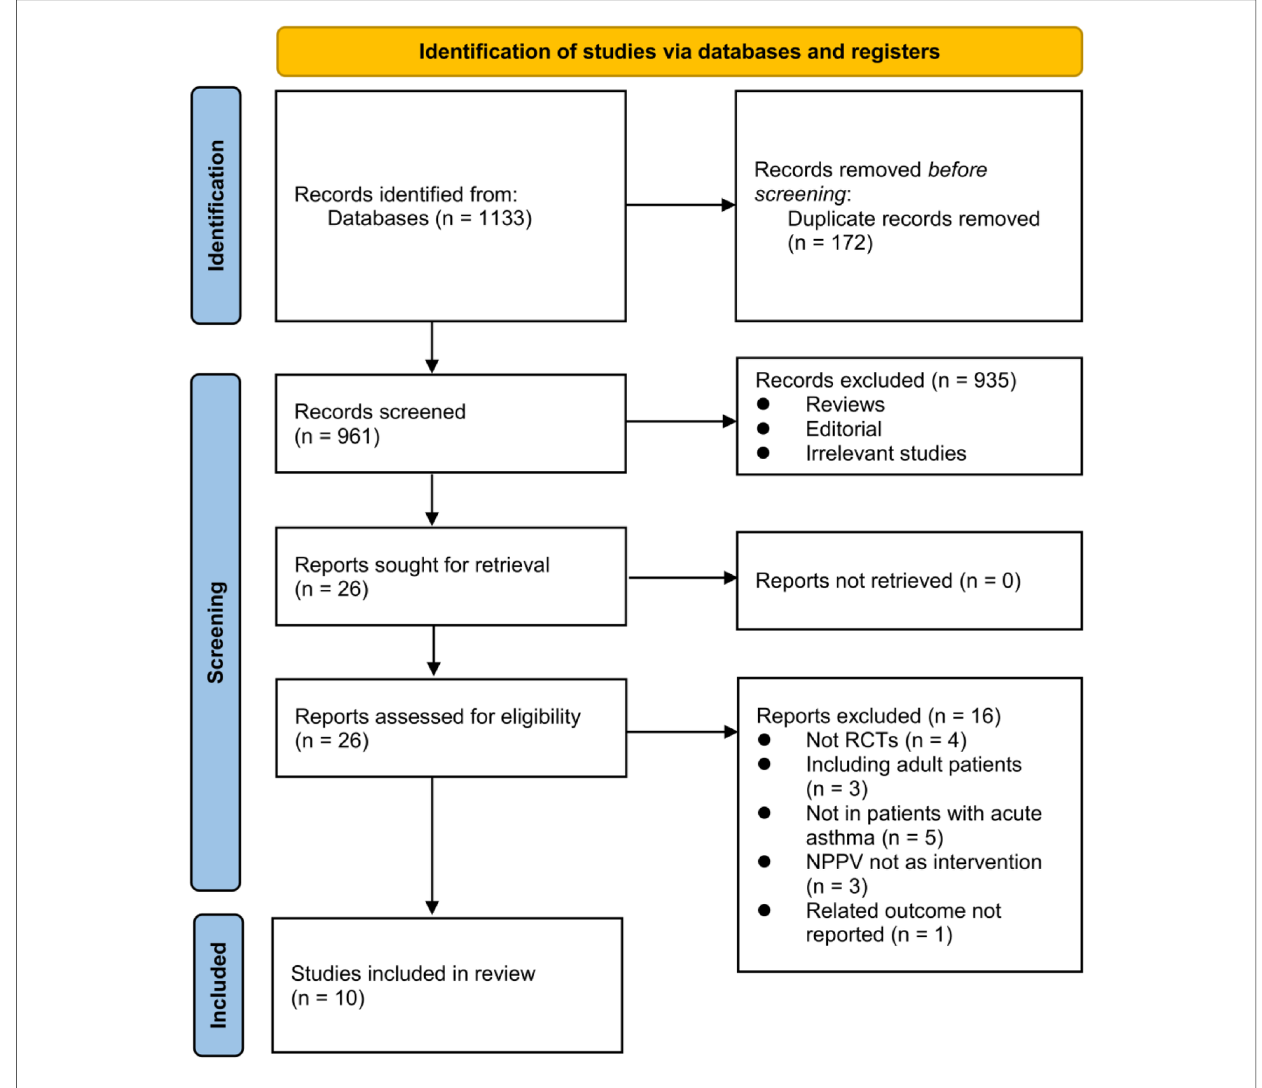
FIGURE 1 Flowchart of literature